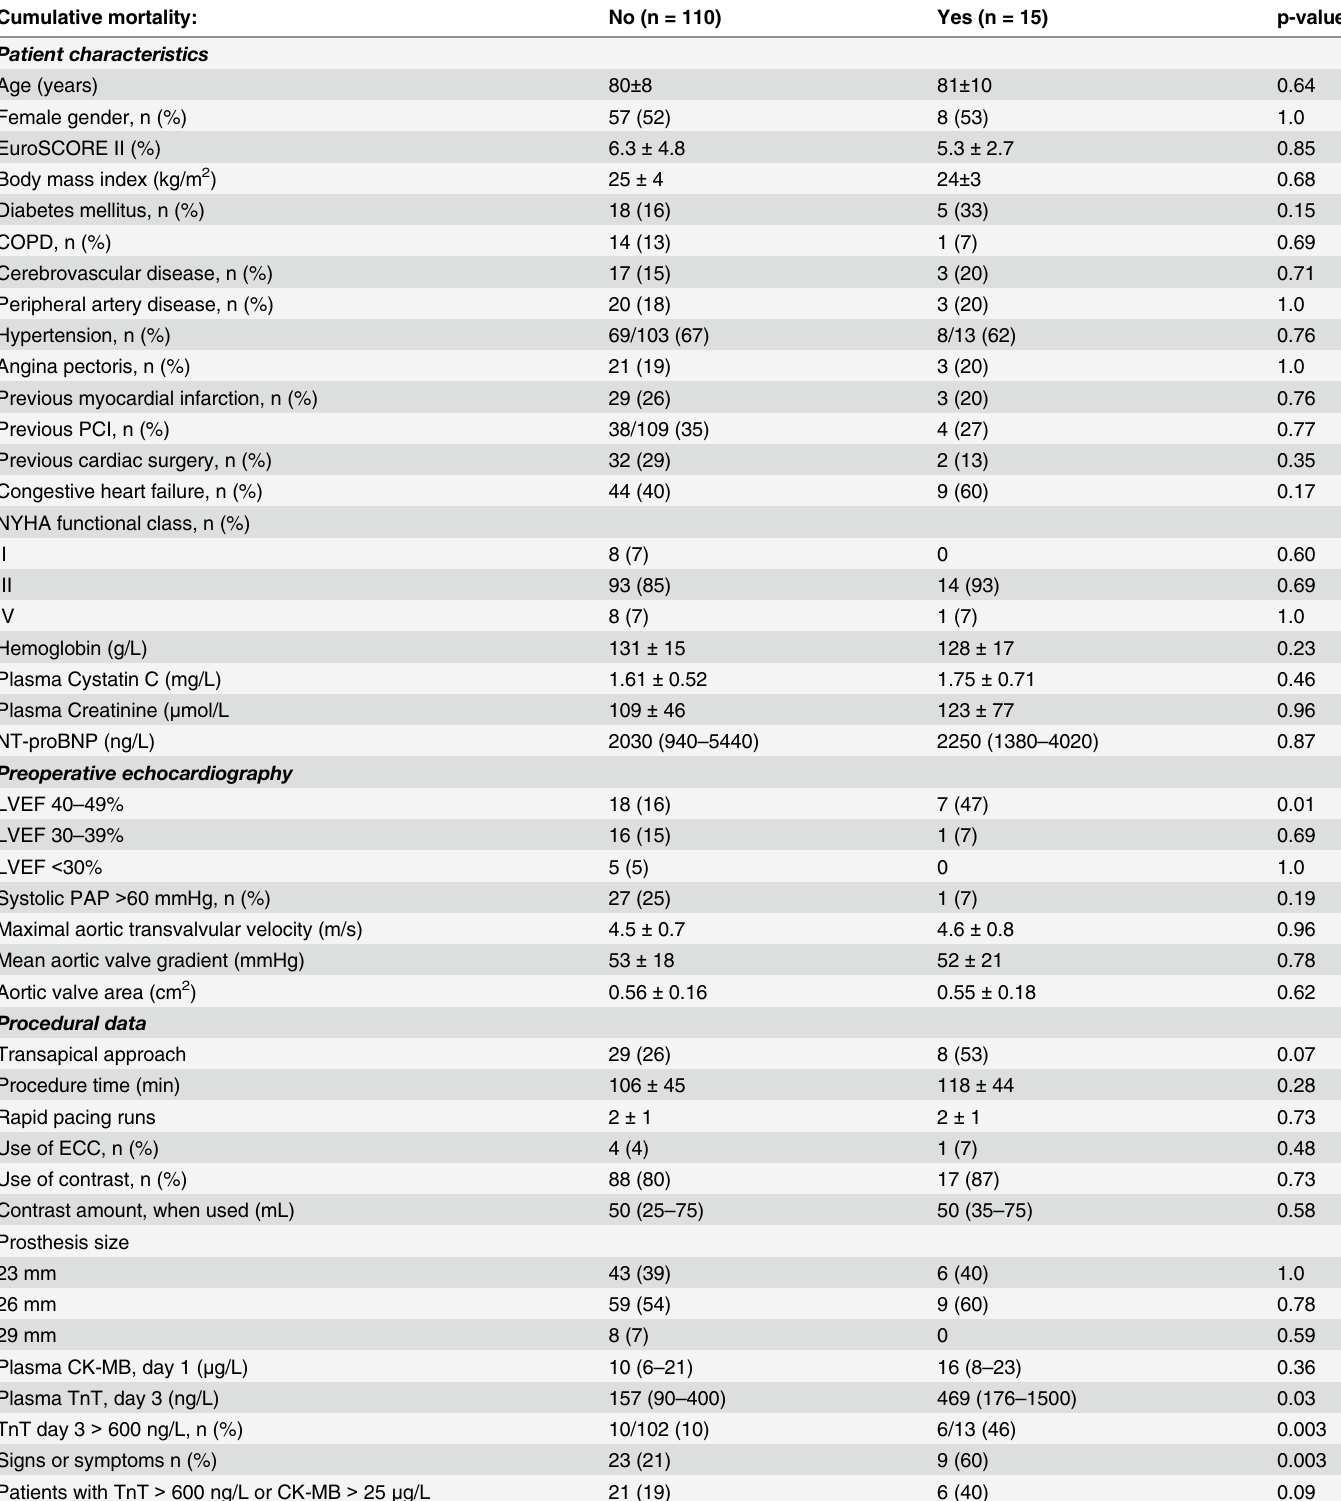
Table 5. Baseline patient characteristics and procedural data according to the cumulative all-cause mortality at 6-months follow-up. Cumulative